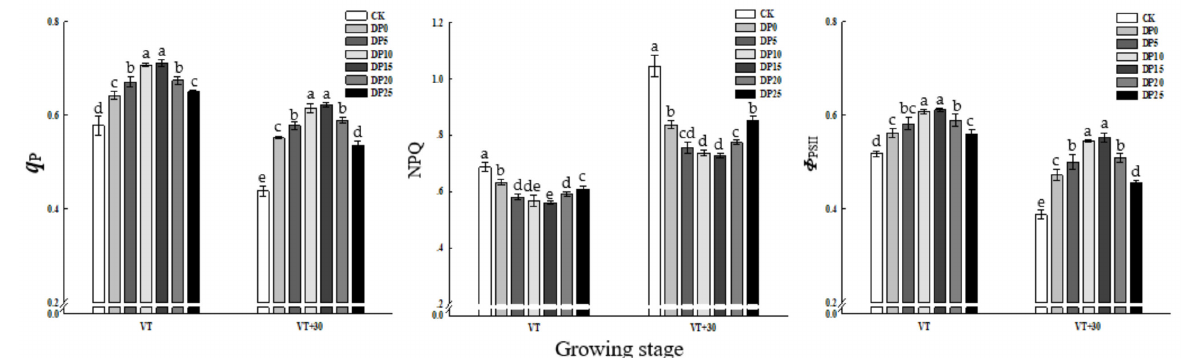
Figure 6. Controlled-release urea depth of different base on summer maize ear lobe photochemical quenching ( q P ), non-photochemical quenching (NPQ), and quantum yield ( Φ PSII ). CK: no fertilizer; DP0: surface application; DP5: fertilization depth 5 cm; DP10: fertilization depth 10 cm; DP15: fertilization depth 15 cm; DP20: fertilization depth 20 cm; DP25: fertilization depth 25 cm. Thin vertical bars are standard errors ( n = 15). Different letters in each column indicate significant differences at p < 0.05